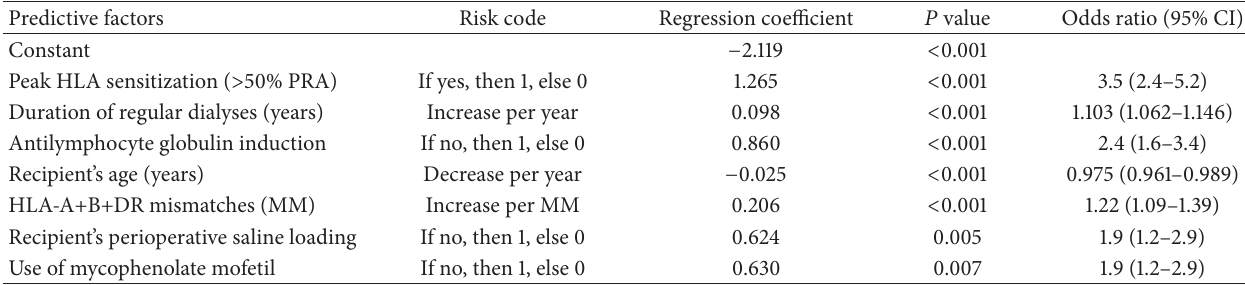
Table 4: Multivariable logistic regression analysis of factors predicting acute rejection episodes occurring during the delayed graft function period in 1784 transplants performed from 1983 to 2014.